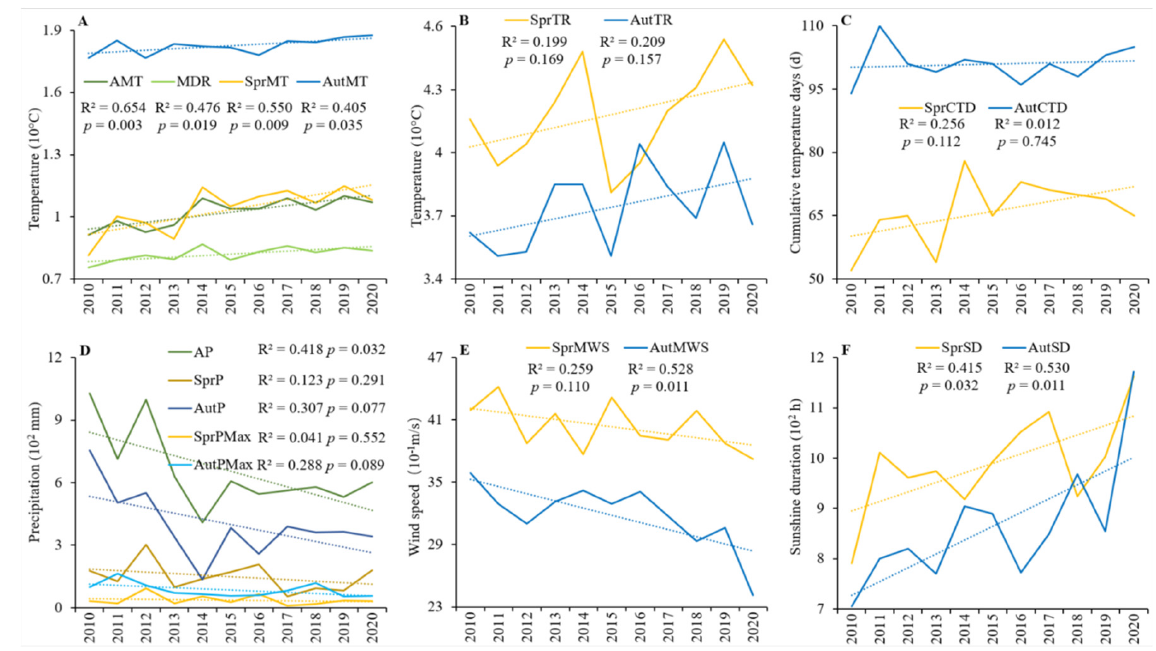
Figure 5. Changes in climatic variables from 2010 to 2020. Variables include ( A ) Annual mean temperature (AT), annual mean diurnal temperature range (MDR); seasonal mean temperature (SprT and AutT); ( B ) Seasonal temperature range (SprTR and AutTR); ( C ) Seasonal cumulative temperature days (SprCTD and AutCTD); ( D ) Annual precipitation (AP), seasonal precipitation (SprP and AutP), maximum seasonal precipitation (SprPMax and AutPMax); ( E ) Seasonal mean wind speed (SprMWS and AutMWS); and ( F ) Seasonal sunshine duration (SprSD and AutSD). “Spr” for spring and “Aut” for autumn.